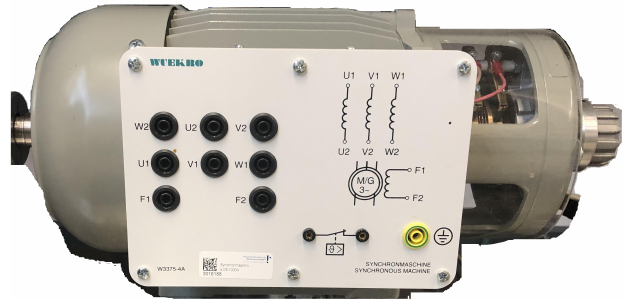
Figure 7. WUEKRO Wound Rotor Separated Excited Synchronous Motor